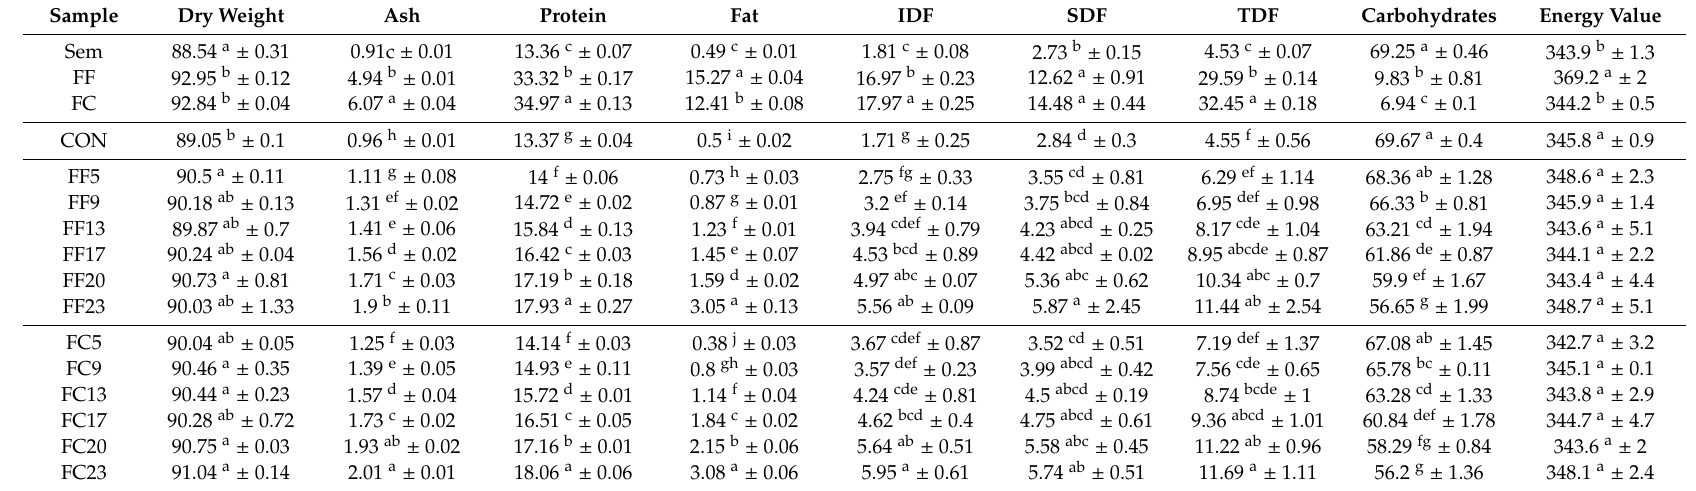
Table 5. Chemical composition [% d.b.] and energy value [kcal / 100g] of raw materials and pasta with flaxseed flour (FF) and flaxseed cake